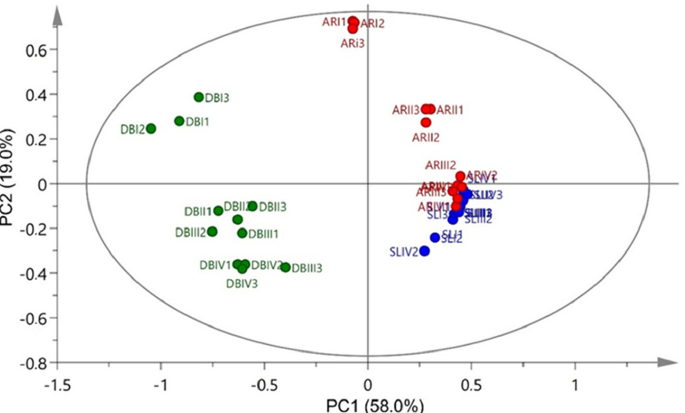
Figure 3. Principal component analysis of 1 H NMR data, score scatter plot of PC1 versus PC2. The ellipse represents the Hotelling T2 with 95% confidence. ‘Di Benedetto’ (DB); ‘Arborea’ (AR); ‘Santa Lucia’ (SL). Numbers I–IV refer to the stages, as indicated in Table 1. Numbers 1–3 indicate different replicates.